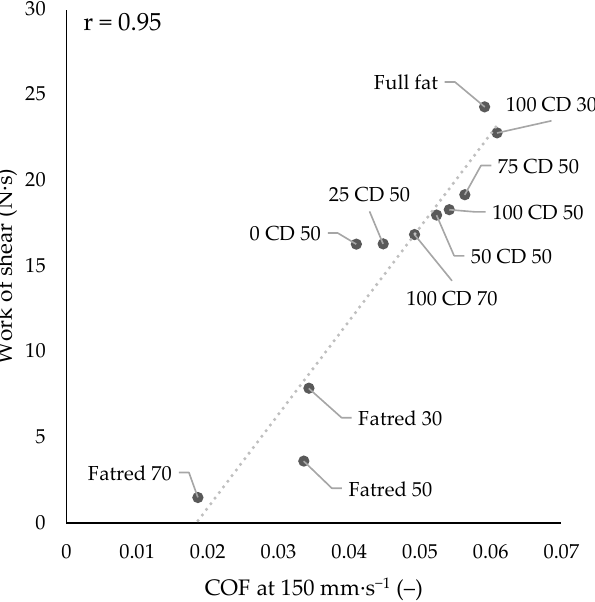
Figure A1. Correlation between work of shear and the COF at a sliding speed of 150 mm · s − 1 (r = correlation coefficient).